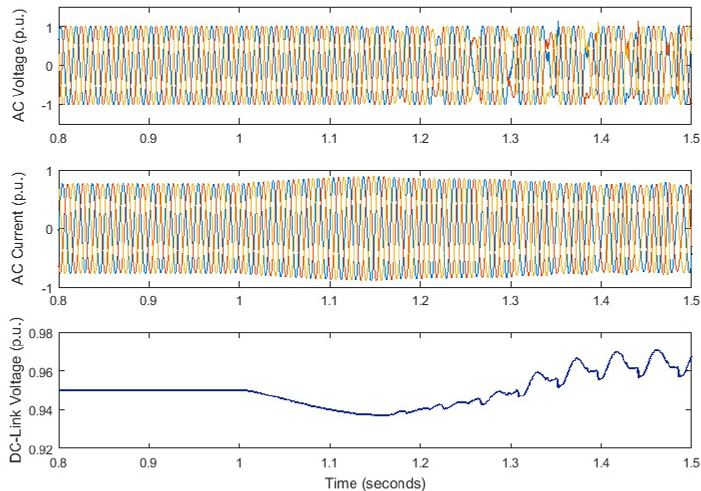
Figure 11. Inverter input and output simulation results for step load increase.